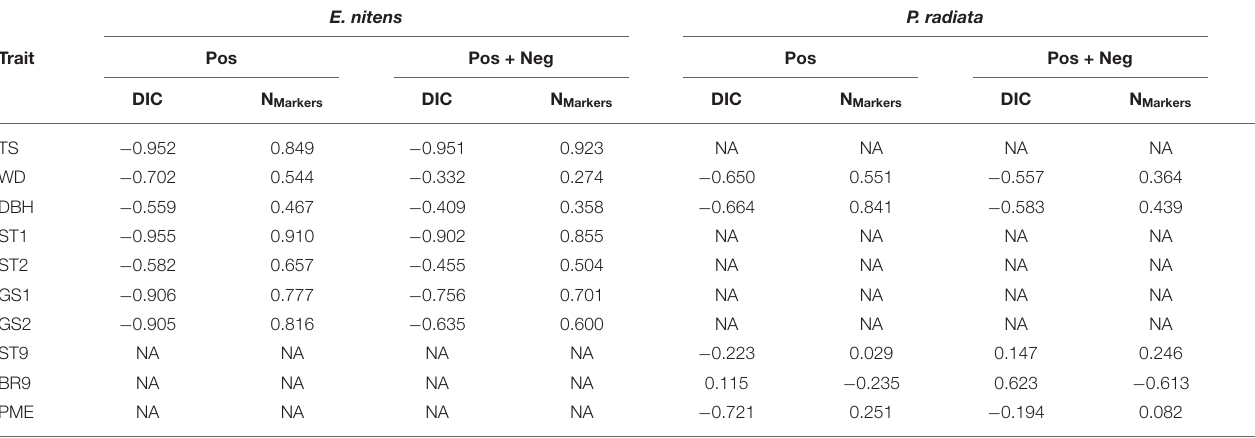
TABLE 5 | Correlations between prediction accuracy and Deviance Information Criterion (DIC) and between prediction accuracy and number of selected